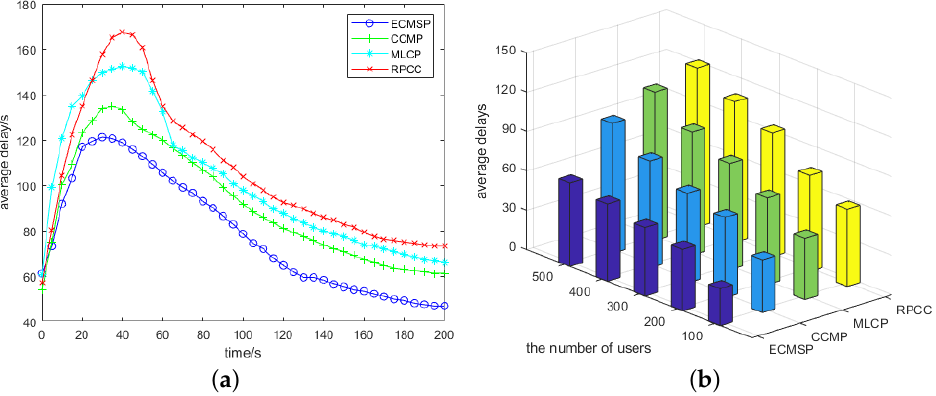
Figure 7. Comparison of time delay performance of four caching schemes: ( a ) average delay with the simulation time; ( b ) average delay with the number of the mobile